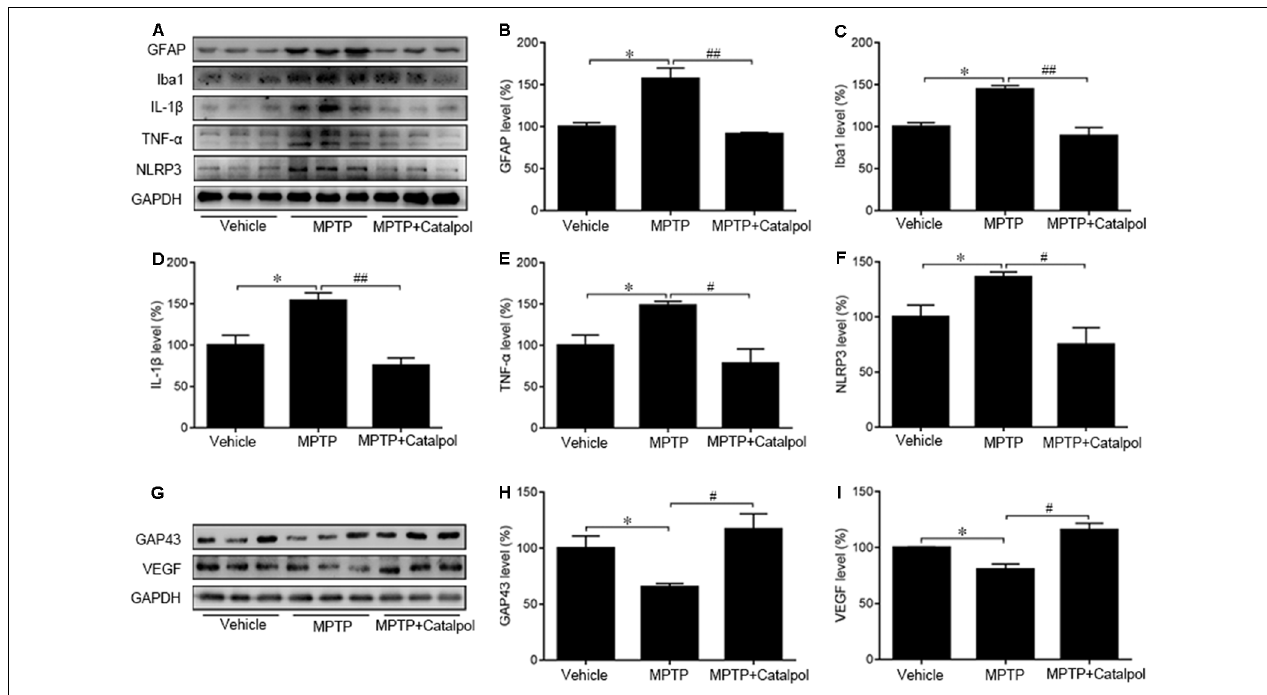
FIGURE 7 | Catalpol suppresses MPTP-induced inflammation and promotes neural regeneration in the SN of mice. (A) Western blot analysis of GFAP, Iba1, IL-1 β , TNF- α , and NLRP3 protein expression in the SN of mice. (B–F) Catalpol blocks MPTP-induced astrocyte and microglia activation inhibits IL-1 β and TNF- α , and suppresses NLRP3 production. (G–I) Growth-associated protein 43 (GAP43) and vascular endothelial growth factor (VEGF) protein expression detected by western blotting. Data represent mean ± SEM; n = 7 mice per group. The P -values were calculated using one-way ANOVA. ∗ P < 0.05 vs. vehicle group; # P < 0.05, ## P < 0.01 vs. MPTP-induced